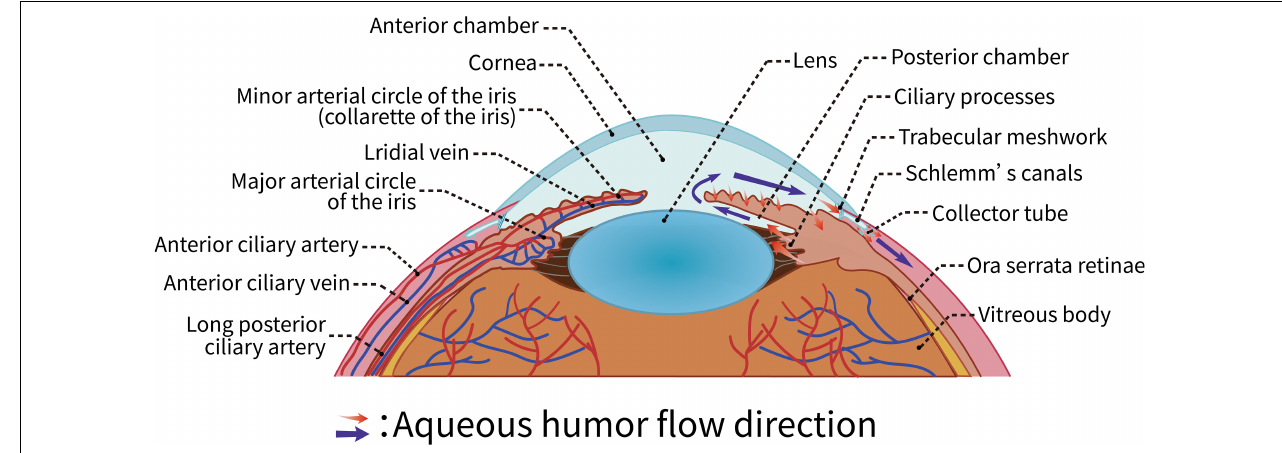
FIGURE 3 | Aqueous humor circulation